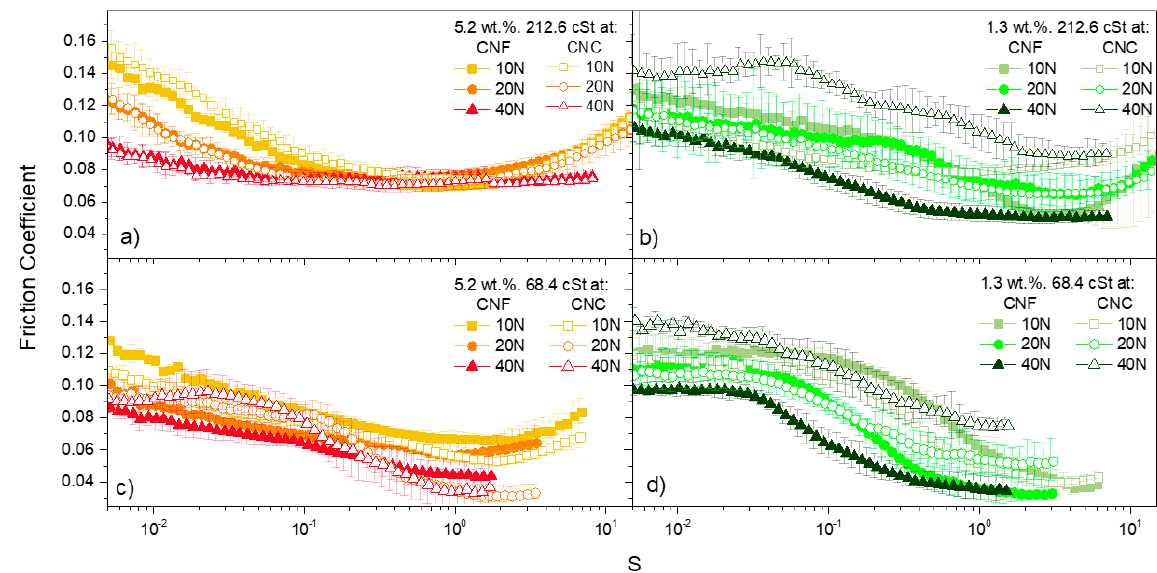
Figure 5. Comparison of the friction coefficient as a function of applied normal force for CNF-based (filled symbol) and CNC-based (empty symbol) ecolubricants, at 25 ◦ C, at selected combinations of base oil viscosity and nanocellulose concentration: ( a ) 5.2 wt.% and 212.6 cSt; ( b ) 1.3 wt.% and 216.6 cSt; ( c ) 5.2 wt.% and 68.4 cSt; ( d ) 1.3 wt.% and 68.4 cSt.